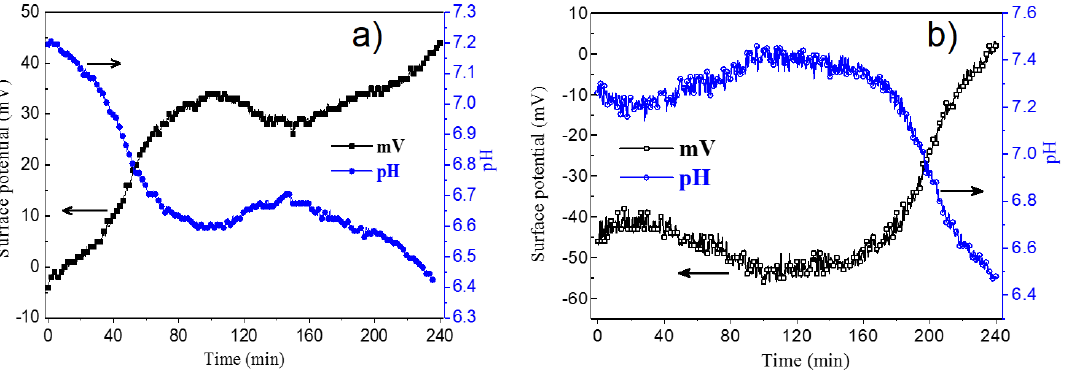
Figure 4. Surface potential and local pH of the ZnO / Cu x = 1.25 O nanowires under: ( a ) simulated solar light and ( b ) visible light irradiation during SMT degradation. Solution parameters: [catalyst] = 500 mg / L, [SMT] = 2.5 mg / L and initial pH 7.0.